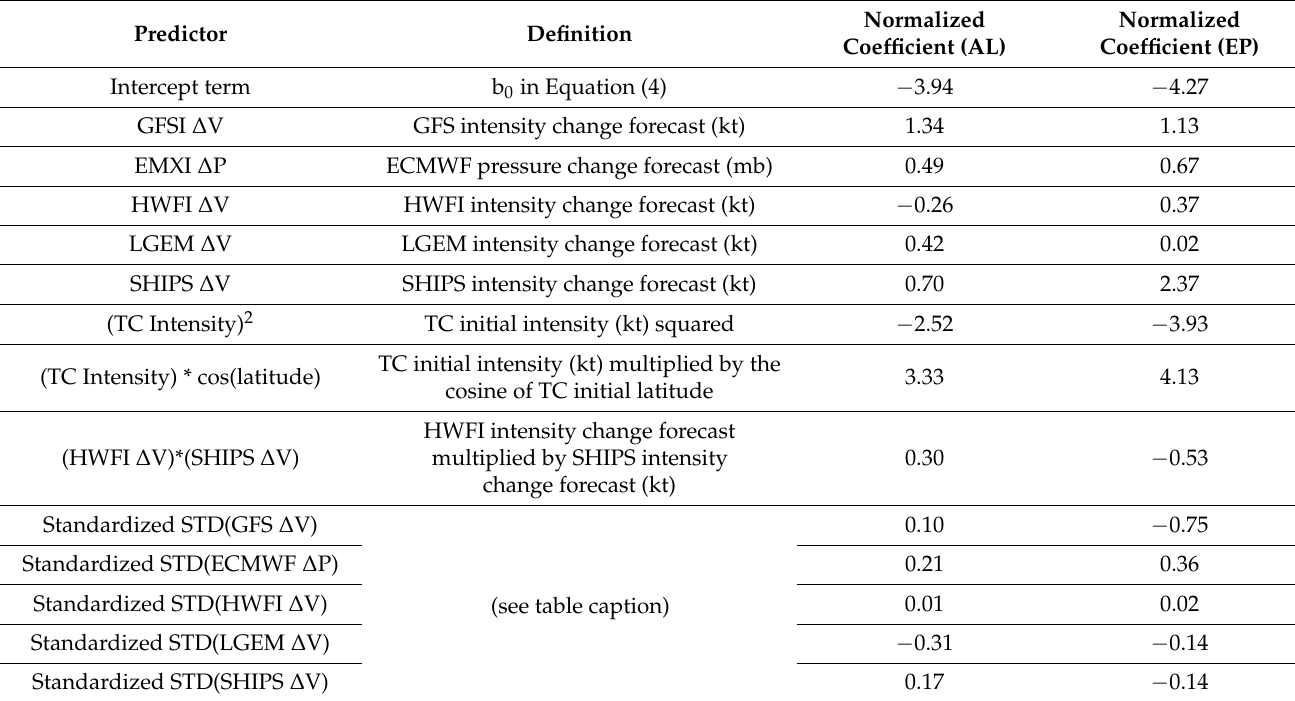
Table 4. DTOPS term definitions and standardized coefficients for the Atlantic (AL) and eastern North Pacific (EP) models. All terms are standardized by subtracting the mean and dividing by the standard deviation. Each of the standard deviation (STD) terms in rows 10–14 are step function terms that have a value of either 0 or 1 before standardization. If the ∆ V (forecast change in maximum wind) or ∆ P (forecast change in minimum pressure) exceeds 1.25 standard deviations, the pre-normalization value is set to